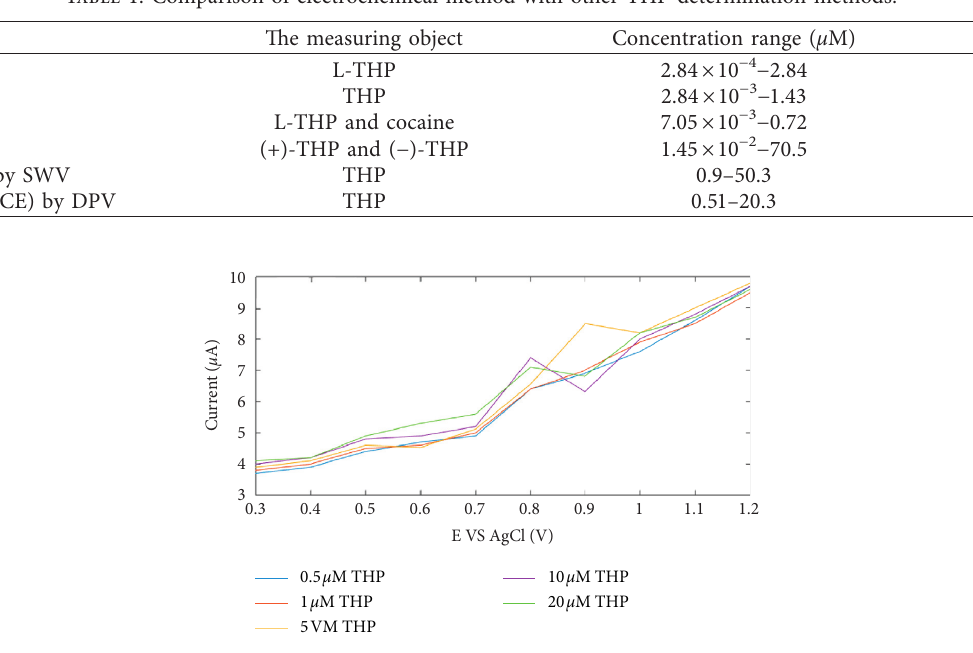
Figure 1: Differential pulse voltammetry of NiNPs/SGS/GCE at different concentrations of 0.5–20.0 μ m THP. Table 2: Determination results of recovery rate of drug solution with different concentrations.